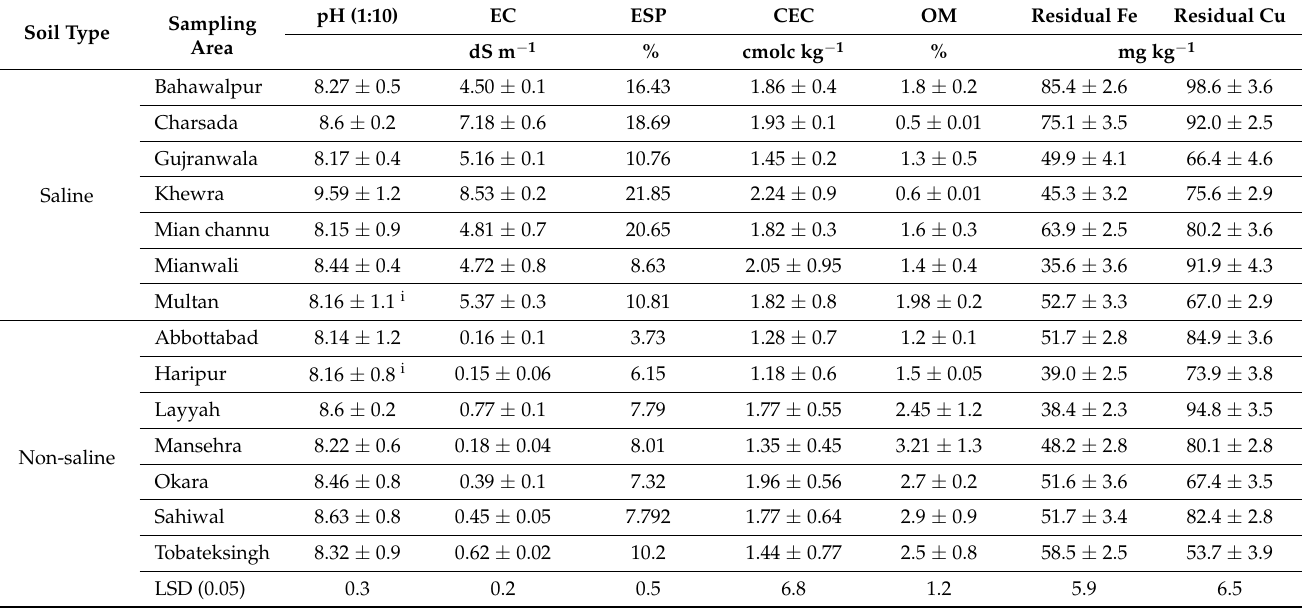
Table 3. Geochemical analysis of selected soils.